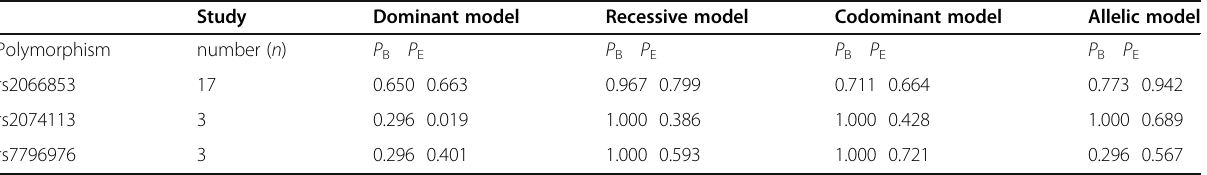
Table 4 Publication bias results of Begg ’ s and Egger ’ s